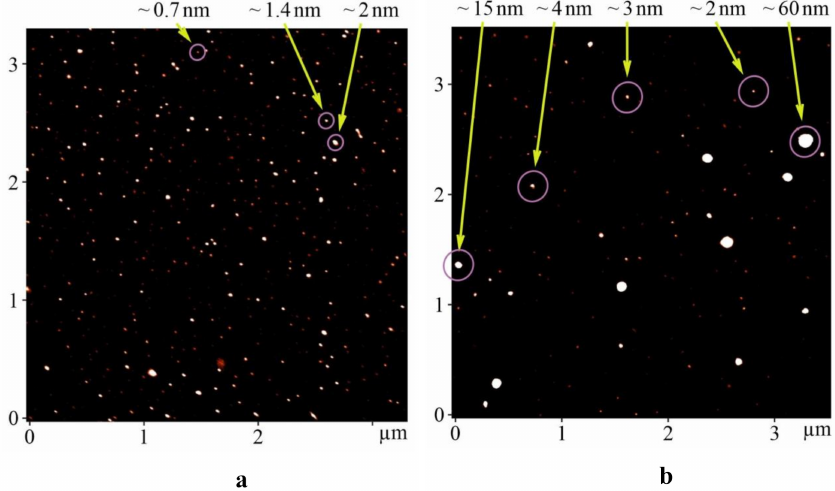
Figure 1. AFM images (tapping mode) of C 60 fullerene nanoparticles on the mica surface (concentra- tion 0.15 mg/mL) ( a ) objects with a height of ~0.7 nm ( b ) objects with a height of 1.4–60